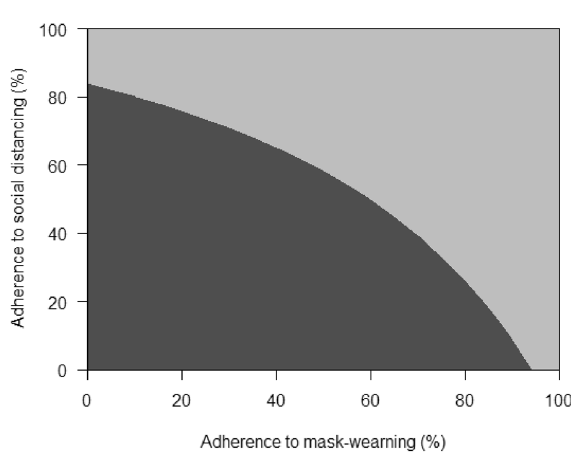
Figure 4. Daily COVID-19-attributable deaths under resumption and relaxation of restrictions between June 2020 and May 2021: ( A ) without adherence to social distancing and ( B ) with 50% adherence to social distancing. Each colored line indicates the level of mask adherence at 0% (red), 50% (orange), 70% (green) or 90% (blue).